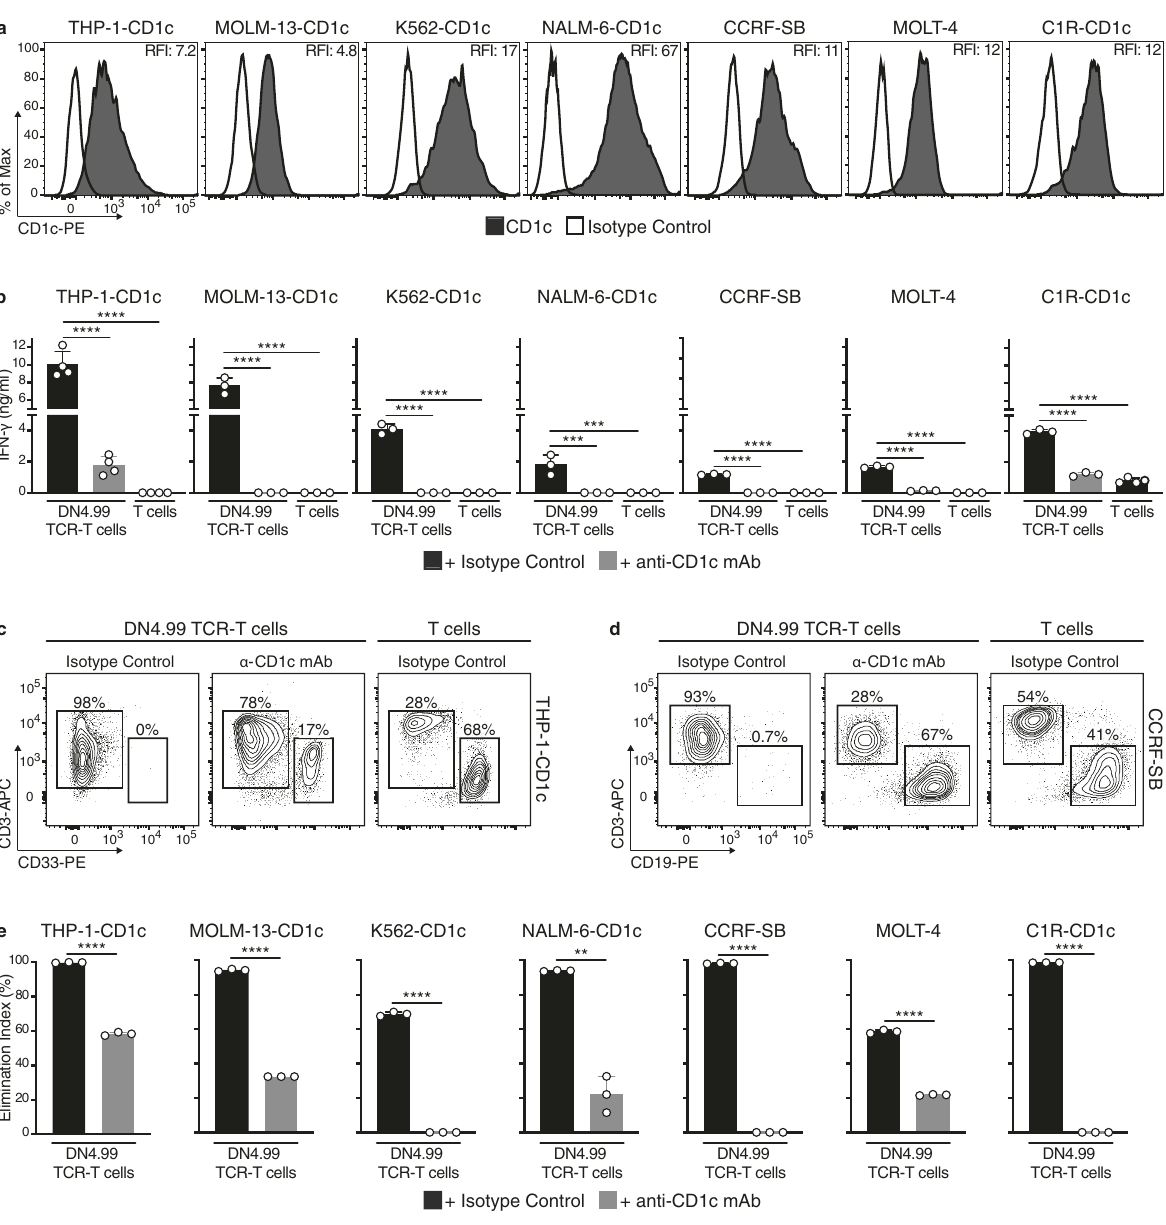
Fig. 4 DN4.99 TCR-T cells ef fi ciently recognize and kill CD1c + leukemia-cell lines. Primary T cells were transduced (DN4.99 TCR-T cells) or not- transduced (T cells) with the lead DN4.99 TCR and assessed in vitro for the recognition and killing of CD1c-expressing acute leukemia or lymphoblastoid cell lines. a CD1c expression (black histograms) on 7 different acute leukemia (THP-1, MOLM-13, K562, NALM-6, CCRF-SB, MOLT-4) or lymphoblastoid (C1R) cell lines, as determined by fl ow cytometry measurement of labeling with anti-human CD1c monoclonal antibody (mAb). White histograms represent labeling with isotype-matched control mAb. Relative Fluorescence Intensity (RFI) was calculated as the ratio between intensity of labeling of the sample and control. b Recognition of CD1c-expressing acute leukemia or lymphoblastoid cell lines by DN4.99 TCR- transduced or non-transduced primary T cells following 48 h of co-culture at a 1:1 Effector:Target ratio with either 20 μ g/ml of blocking anti-CD1c mAb (gray bars) or an equivalent concentration of mouse IgG1 κ isotype control (black bars). IFN- γ secretion into supernatants was measured by ELISA. Data are represented as mean ± SD. Results are representative of 2 (for CCRF-SB, MOLT-4 and C1R-CD1c) and 4 (for THP-1-CD1c, MOLM-13-CD1c, K562-CD1c and NALM-6-CD1c) independent experiments with n = 3 replicates per experiments. *** P = 0.0001; **** P < 0.0001 determined by Ordinary one-way ANOVA followed by Tukey ’ s multiple comparison test. c , d Representative fl ow cytometry analysis to assess killing of THP-1-CD1c ( c ) and CCRF-SB ( d ) cells by DN4.99 TCR-T cells after 72 h of the same co-culture conditions of ( b ). e Killing of each target cell line in the same co- cultures determined as shown in ( c , d ), expressed as an Elimination Index as described in Methods. Gray bars represent co-cultures with anti-CD1c mAb, and black bars with the isotype control. Data are represented as mean ± SD. Results are representative of 2 (for K562-CD1c, CCRF-SB, MOLT-4 and C1R-CD1c) and 4 (for THP-1-CD1c, MOLM-13-CD1c and NALM-6-CD1c) independent experiments with n = 3 replicates per experiments. ** P = 0.0071; **** P < 0.0001 determined by unpaired two-tailed Welch ’ s